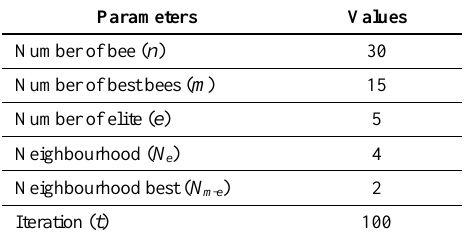
Table 3. Parameters values of Bees Algorithm